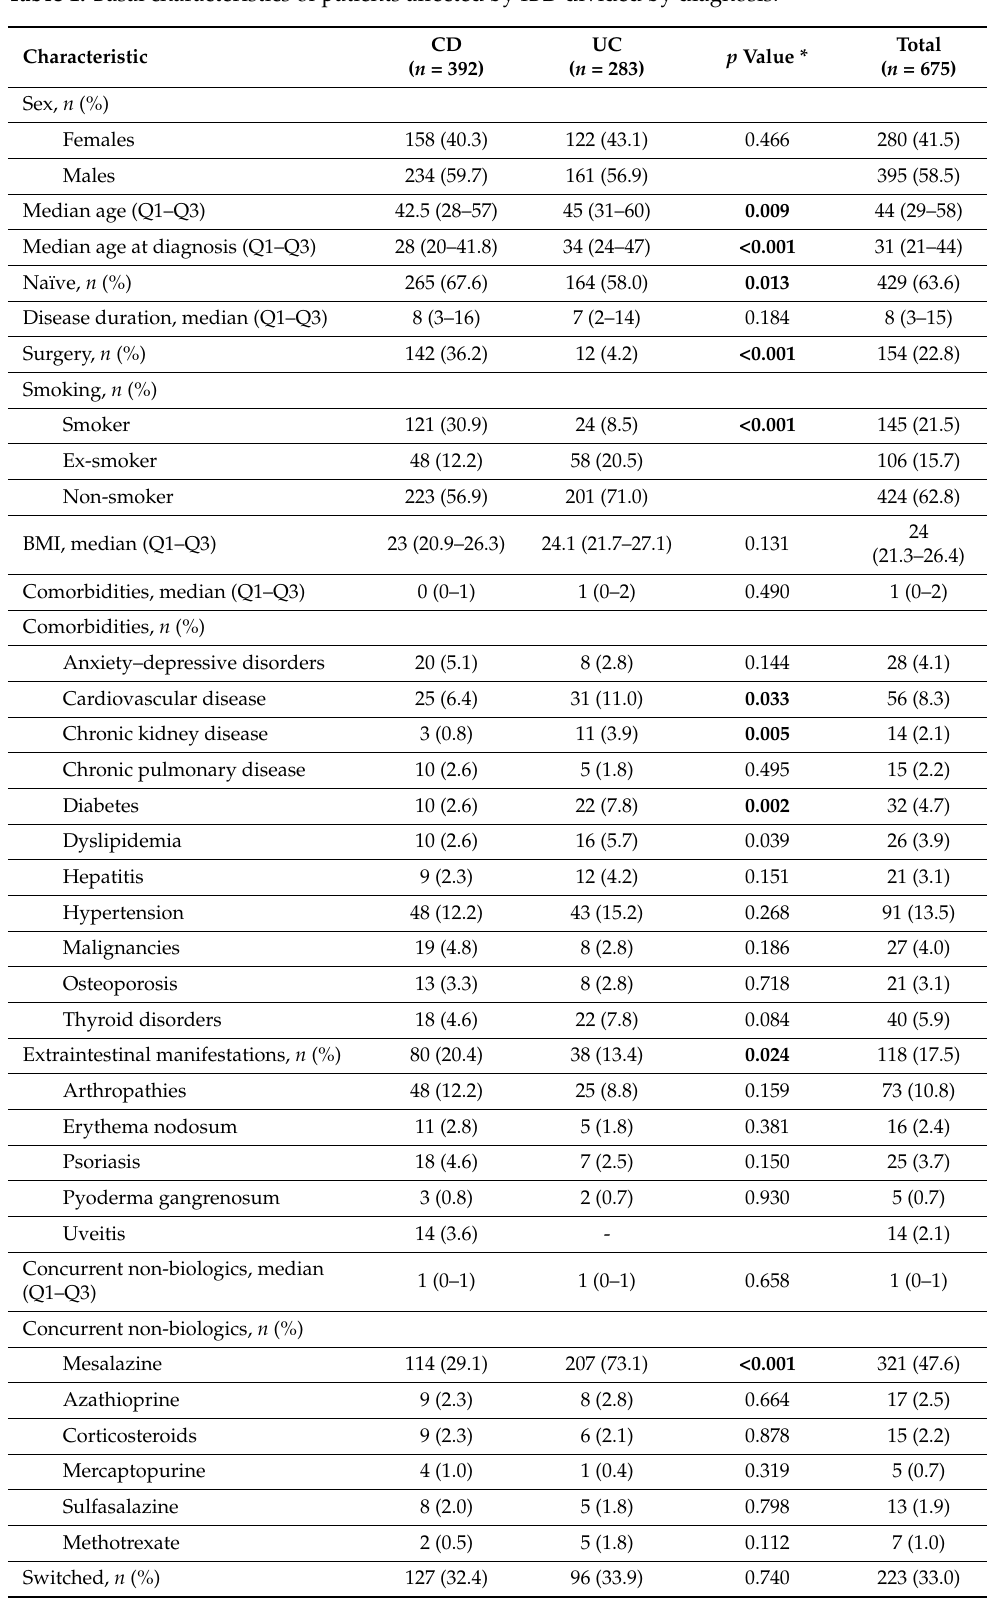
Table 1. Basal characteristics of patients affected by IBD divided by